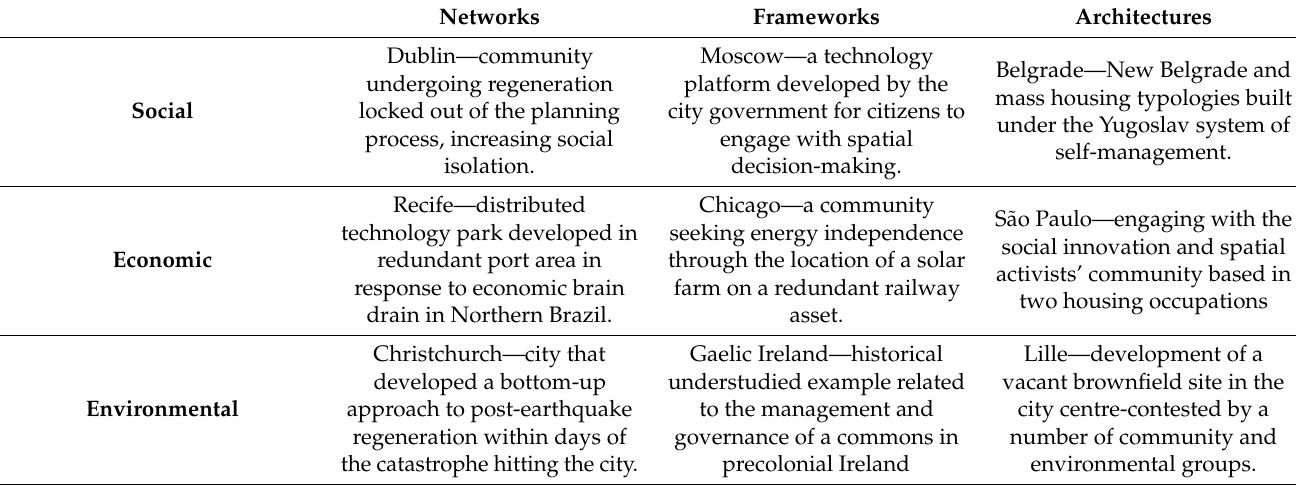
Table 1. Matrix of case